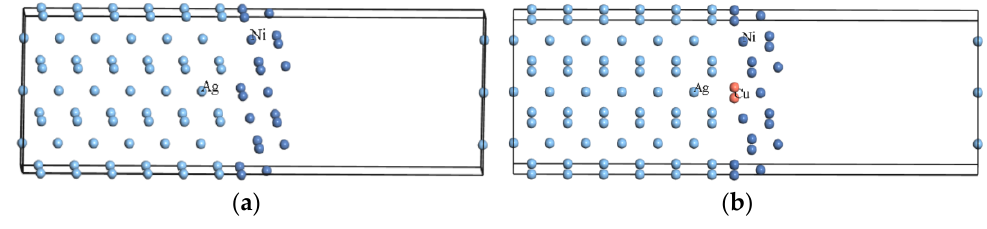
Figure 1. Interface model: ( a ) Ag/Ni, and ( b ) Cu-doped Ag(110)/Ni(211). Table 1. Atomic ratio and mass ratio.